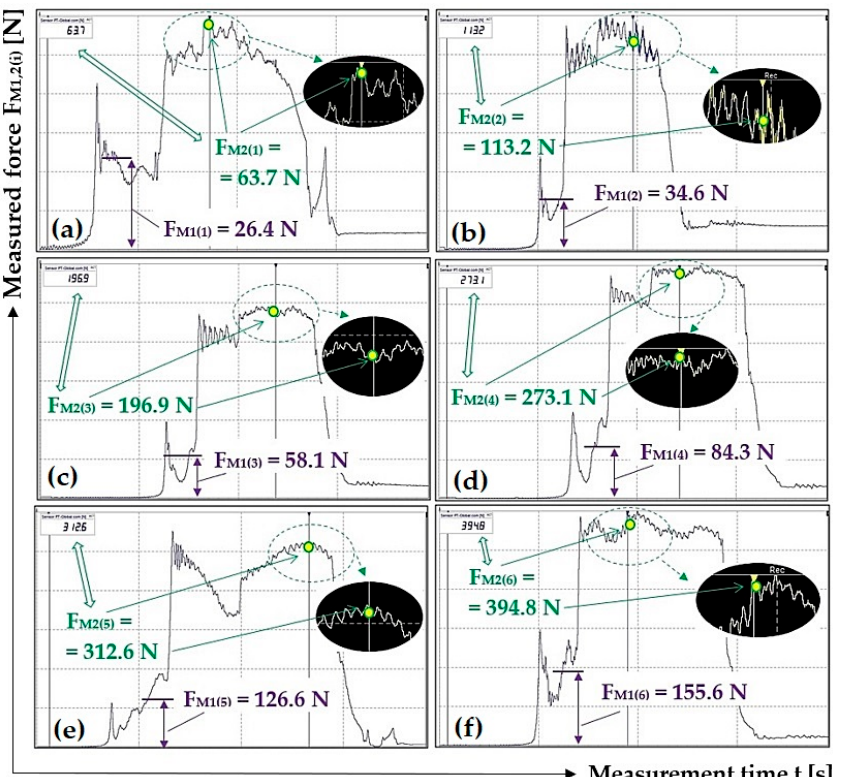
Figure 6. Tensile forces measured using DeweSoft ® software for different load weights at the scraper plough angle of inclination β = 10 deg.